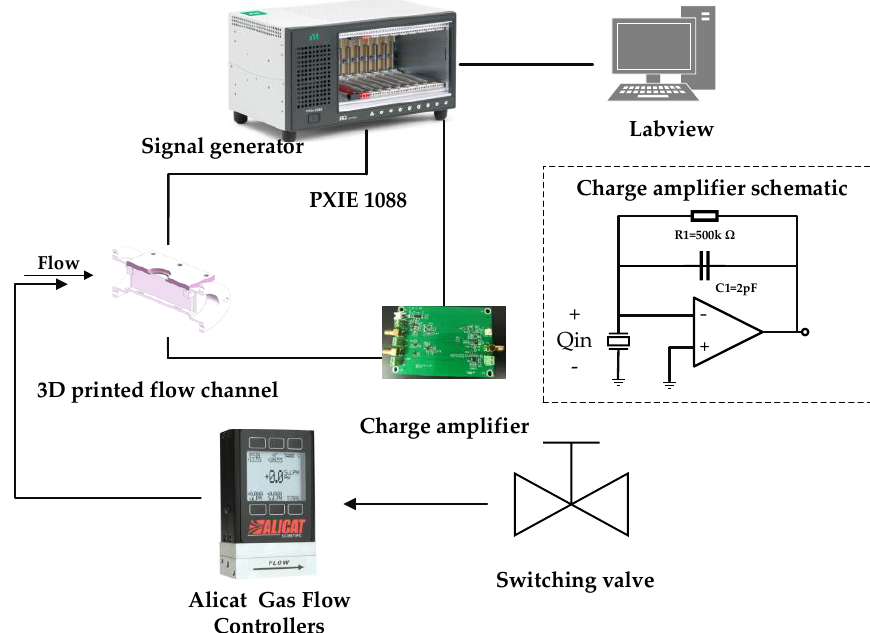
Figure 6. Block diagram of the ultrasonic flowmeter system.